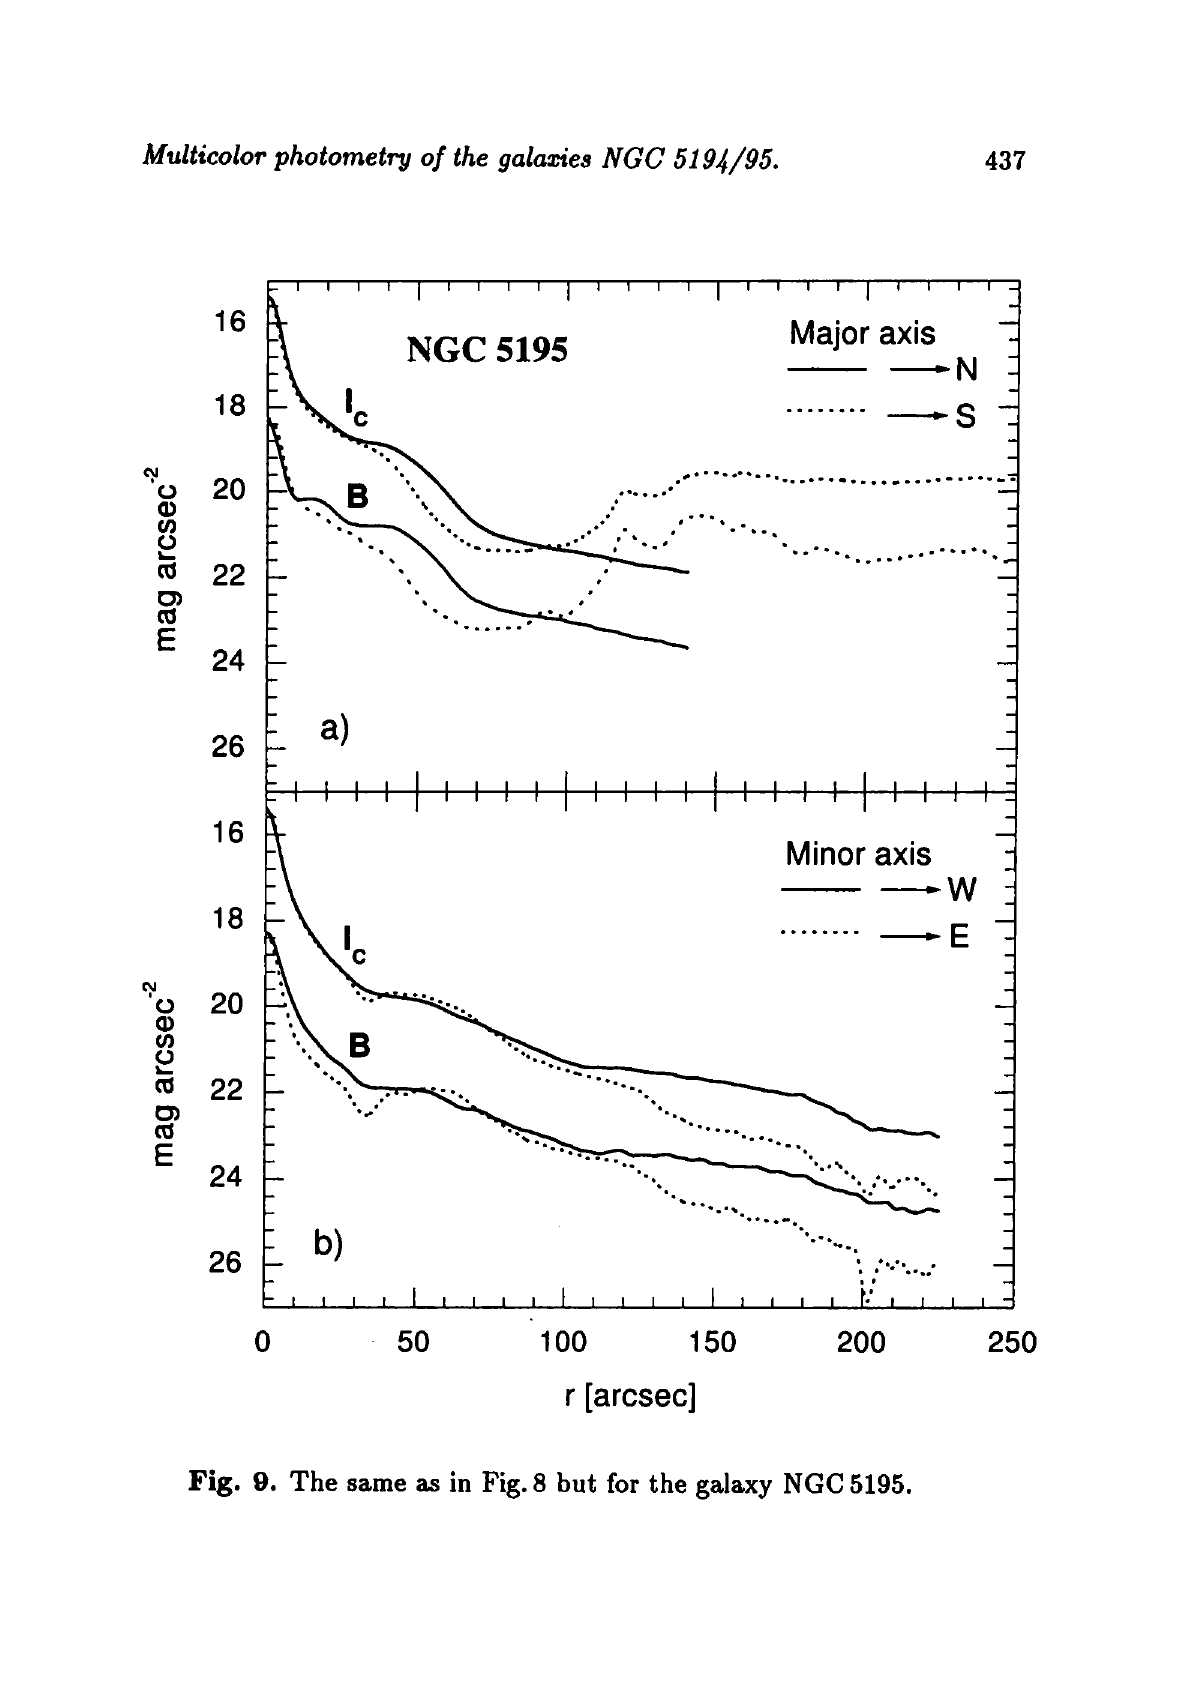
Fig. 9. The same as in Fig. 8 but for the galaxy NGC